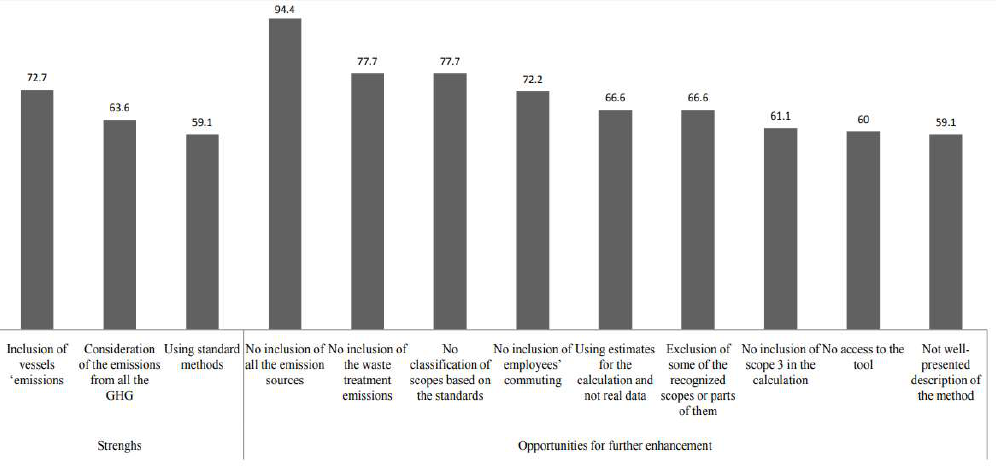
Figure 1. Percentage of the strengths and opportunities for further enhancement of the existing methodologies.